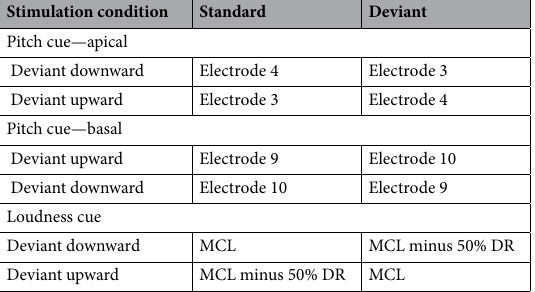
Table 1. Summary of the stimulation conditions. MCL Most comfortable level; DR Dynamic